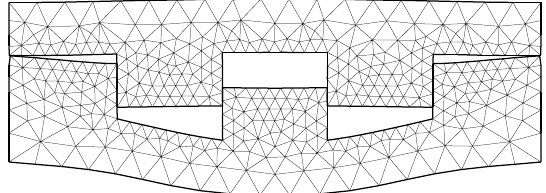
Figure 6.11 . Deformed configuration of the two viscoelastic bodies for µ = 0 . 25ns/m 2 and η = 0 . 1ns/m 2